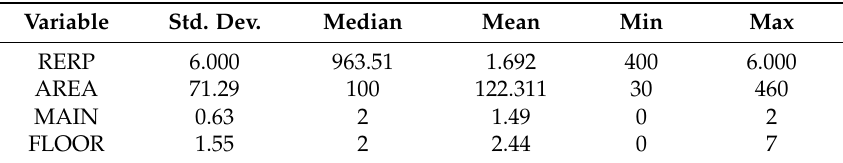
Table 1. Statistical description of real estate data.